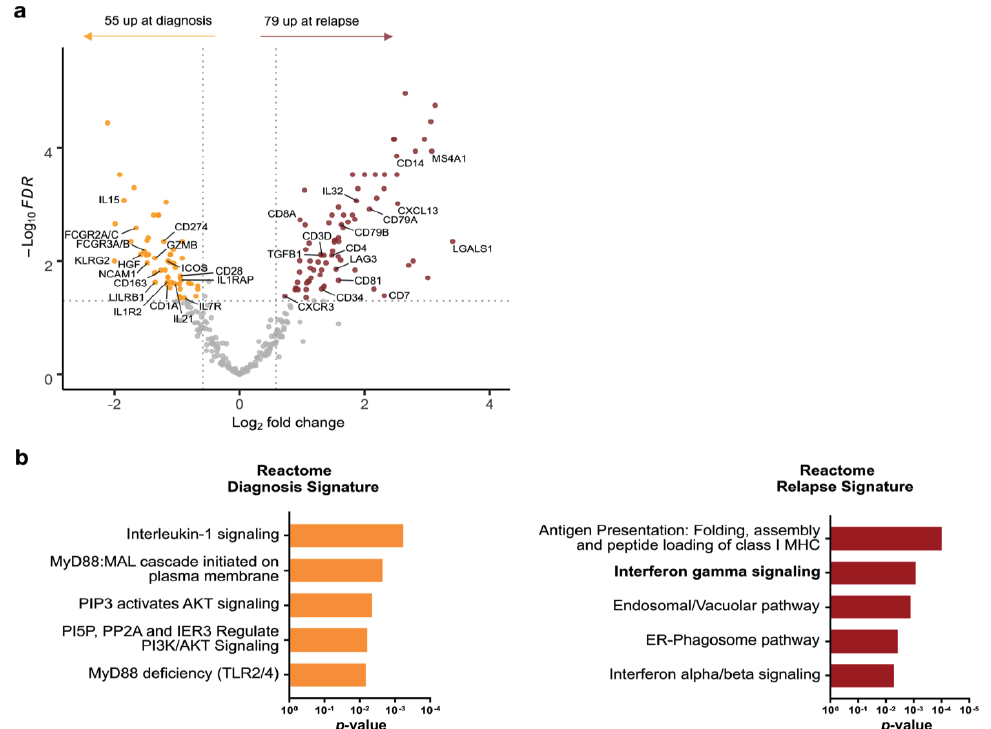
Figure 3. Differential gene expression analysis in paired classical Hodgkin lymphoma samples at diagnosis and relapse: ( a ) volcano plot displaying differentially expressed genes between samples at diagnosis and at relapse. Significantly de-regulated genes (FDR < 0.05 and |fold change| > 1.5) are highlighted in orange (upregulated at diagnosis, n = 55) or red (upregulated at relapse, n = 79); ( b ) top 5 increases in biological processes at diagnosis (orange, left) and at relapse (red, right) identi- fied with REACTOME database, ranked by p -value. FDR = False Discovery Rate.